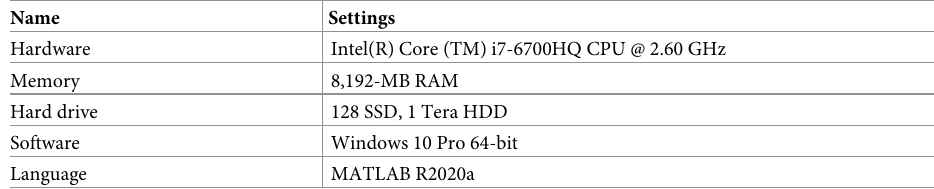
Table 2. Hardware and software of computing